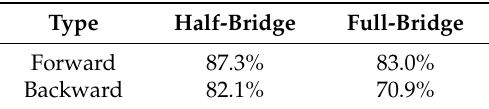
Table 2. Efficiency comparison with load of 200 W.